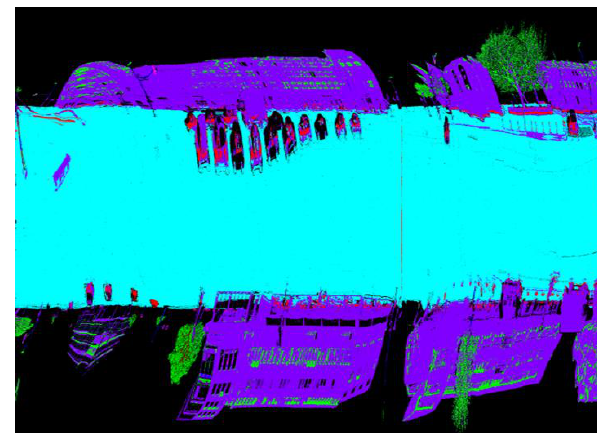
Figure 7: Accurately classified image with aid from data